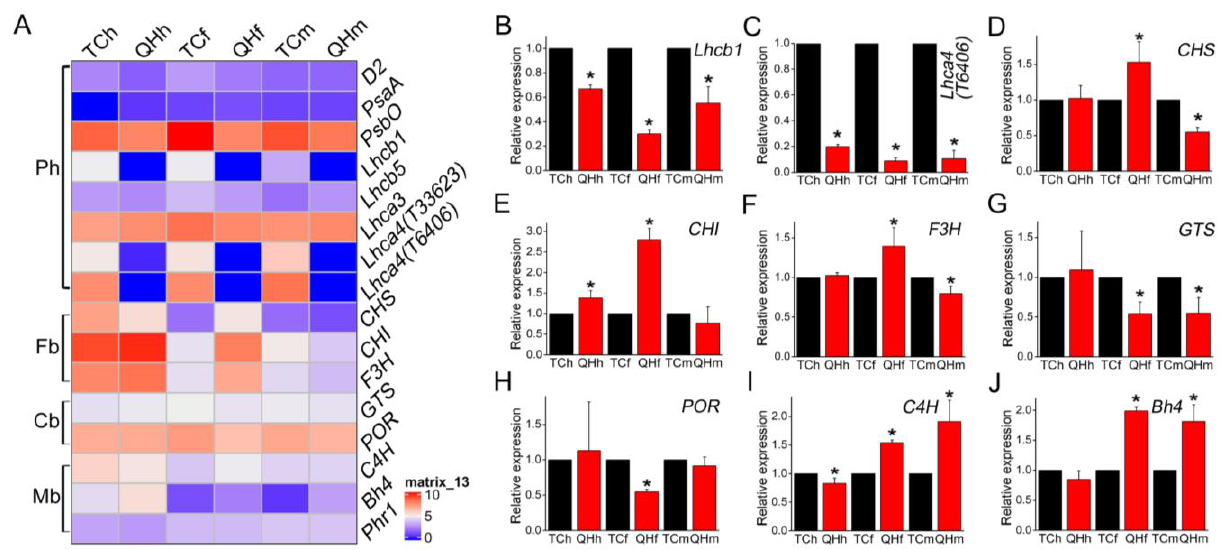
Figure 5. Heatmap and qRT-PCR verification of key genes during oat bract development. ( A ) Heat map analysis of the expression of key genes at the three stages. “Ph”, photosynthesis; “Fb”, flavonoid biosynthesis; “Cb”, chlorophyll biosyn- thesis; “Mb”, melanin biosynthesis. ( B – J ) qRT-PCR analysis of key genes at the three stages. Relative expression values of ‘Qinghai 444’ samples were calculated and normalized with ‘Triple Crown’ as the control in one single stage. The asterisk represents significant differences in relative expression of genes (* p ˂ 0.05, Student’s t -test), with 3 replicates for each ex- periment.